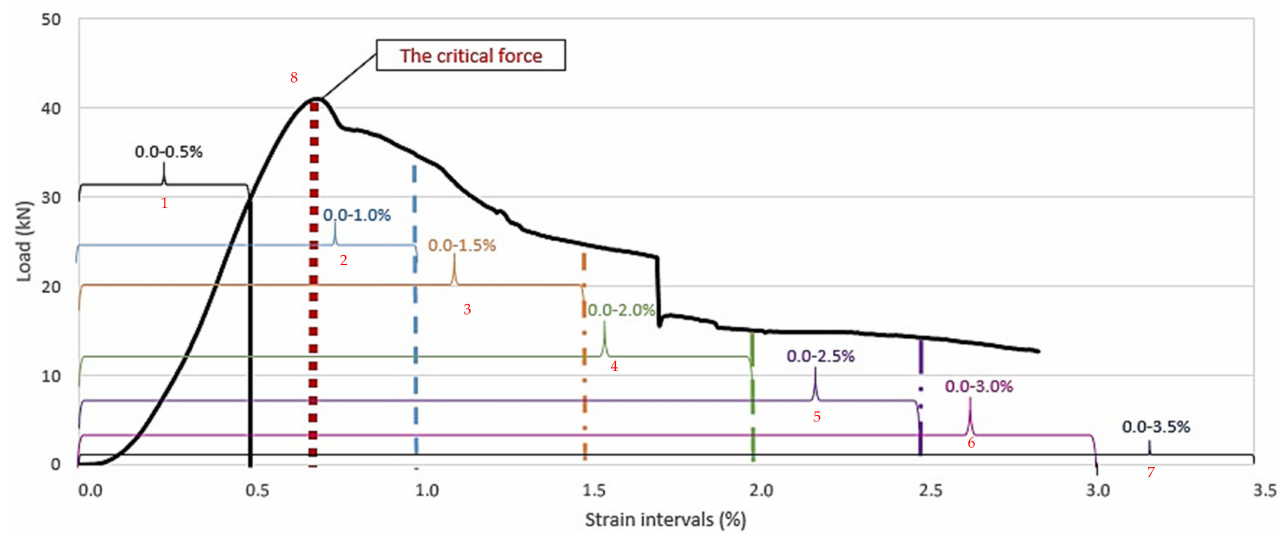
Figure 8. A scheme of strain intervals for which the energy was